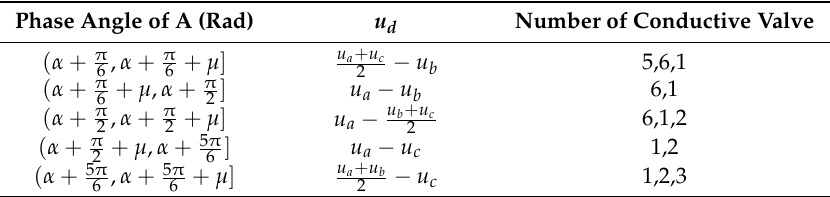
Table 1. DC output voltage of L/C switch equivalent circuit.